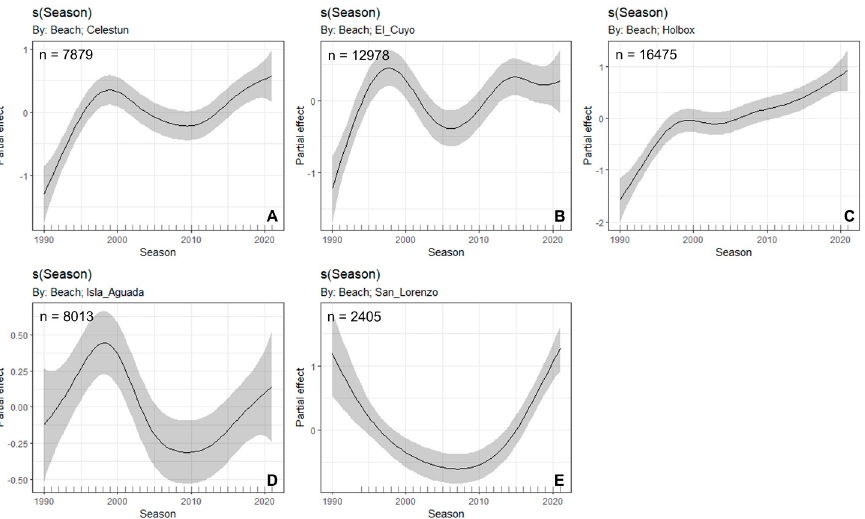
Figure 2. Trends in nest abundance of hawksbill turtles ( Eretmochelys imbricata ) at Celestún ( A ), El Cuyo ( B ), Holbox ( C ), Isla Aguada ( D ), and San Lorenzo ( E ). The black line is the smooth spline line, and the grey areas are the 95% Bayesian confidence intervals. Lechuguillas was excluded from the analysis due to its small sample size, and Cayos Arcas is not a Hawksbill nesting site. Table 1. The average number of hawksbill ( Eretmochelys imbricata ) and green ( Chelonia mydas ) sea turtle nests laid annually (from 1990 to 2021) at seven nesting beaches in the Gulf of Mexico.